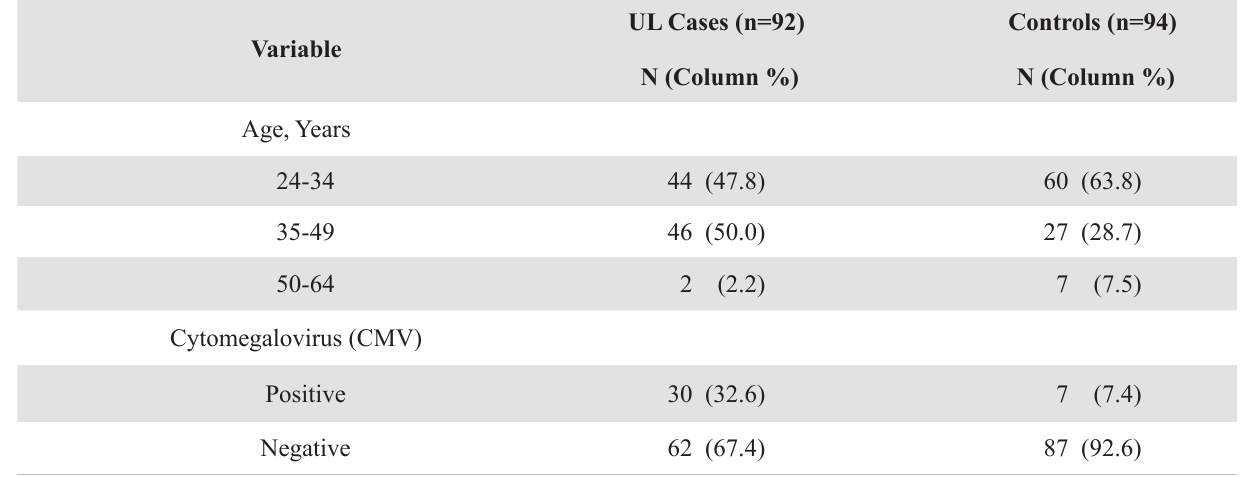
Table 1 . Characteristics of Cases of Uterine Leiomyoma and Control Subjects